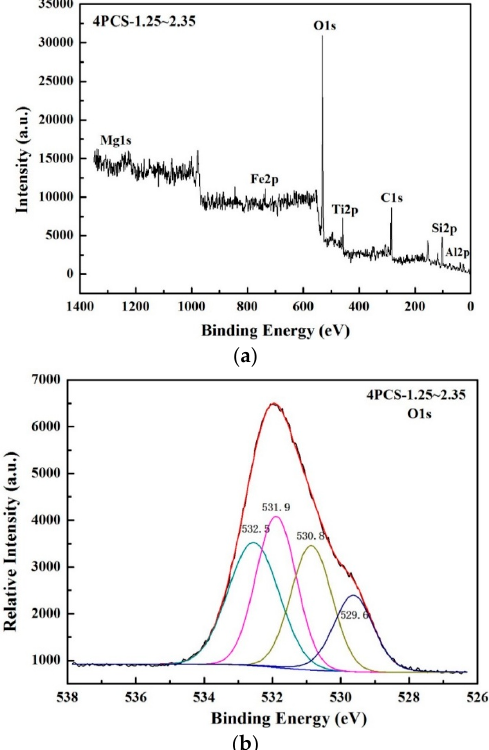
Figure 6. XPS photographs of PCS (4PCS-1.25~2.35); ( a ) survey pattern; ( b ) O1s XPS spectra; XPS: